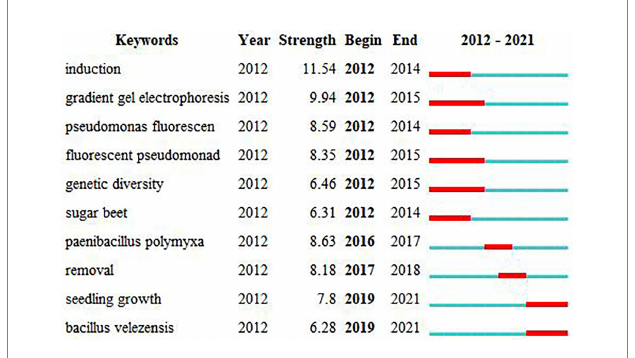
FIGURE 5 Top 10 keywords with the strongest citation